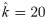
Comparison of five pooling methods.The radar charts show the average number of tests, number of steps, maximum number of samples per pool, number of pipettings (for 1-, 8- and 16-channel pipettes), and the number of additional tests and steps required when the number of positive samples is overestimated (k = 1, k^=20) or underestimated (k = 20, k^=1). The left column shows results from simulations with one positive sample and the right column shows simulations with 20 positive samples. The rows are different sample sizes from top to bottom: 96, 384, and 1,596. In each plot the values for each feature have been Min-Max normalized. In each category, methods with points at the center performed the best while methods with points near the edge performed the worst.